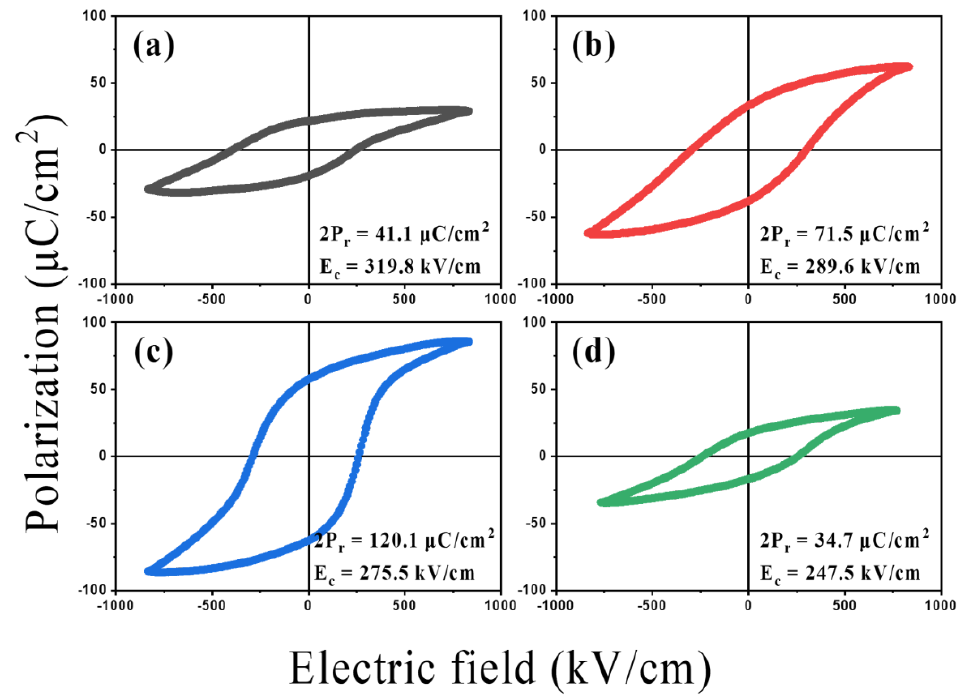
Figure 4. P - E curves of Bi 1− x Gd x FeO 3 films: ( a ) x = 0.00, ( b ) 0.05, ( c ) 0.10, and ( d ) 0.15. Figure 5a plots the leakage current density ( J ) versus the external electric field ( E ) for Bi 1− x Gd x FeO 3 films. Large J is found for BFO film, which might be related to the existence of oxygen vacancies and rougher interfaces. For Gd-substituted films, a dramatic decrease in more than one order of magnitude in leakage is found. The suppressed leakage, possi- bly related to phase transformation and flattened surface, improves FE properties. How- ever, due to the appearance of the paraelectric orthorhombic phase, the FE properties is decreased even though the leakage is further reduced at x = 0.15 in this study.